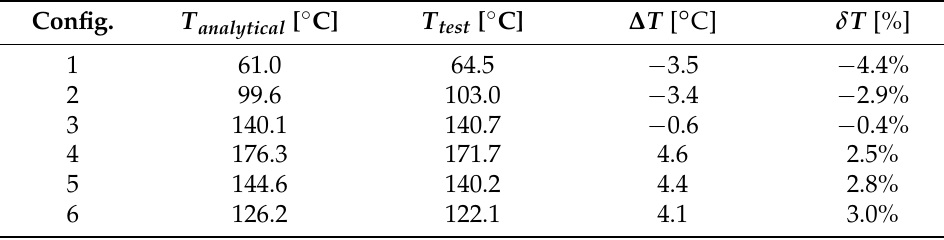
Table 4. Analytical model and test results